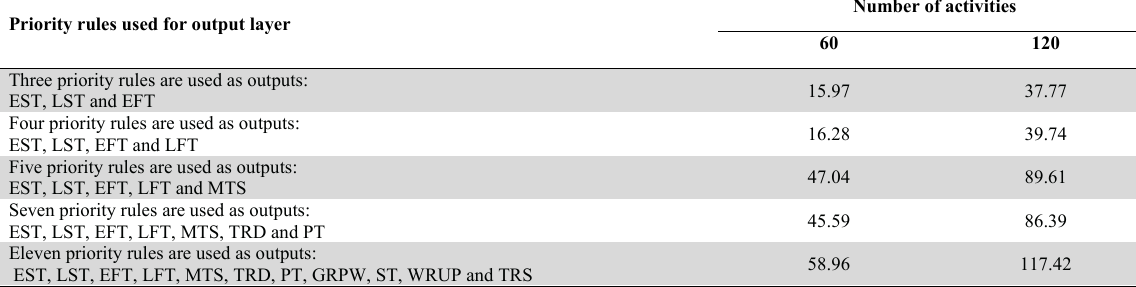
Percentage of average deviations from critical path lower bound for the J60 and J120 Priority rules used for output layer